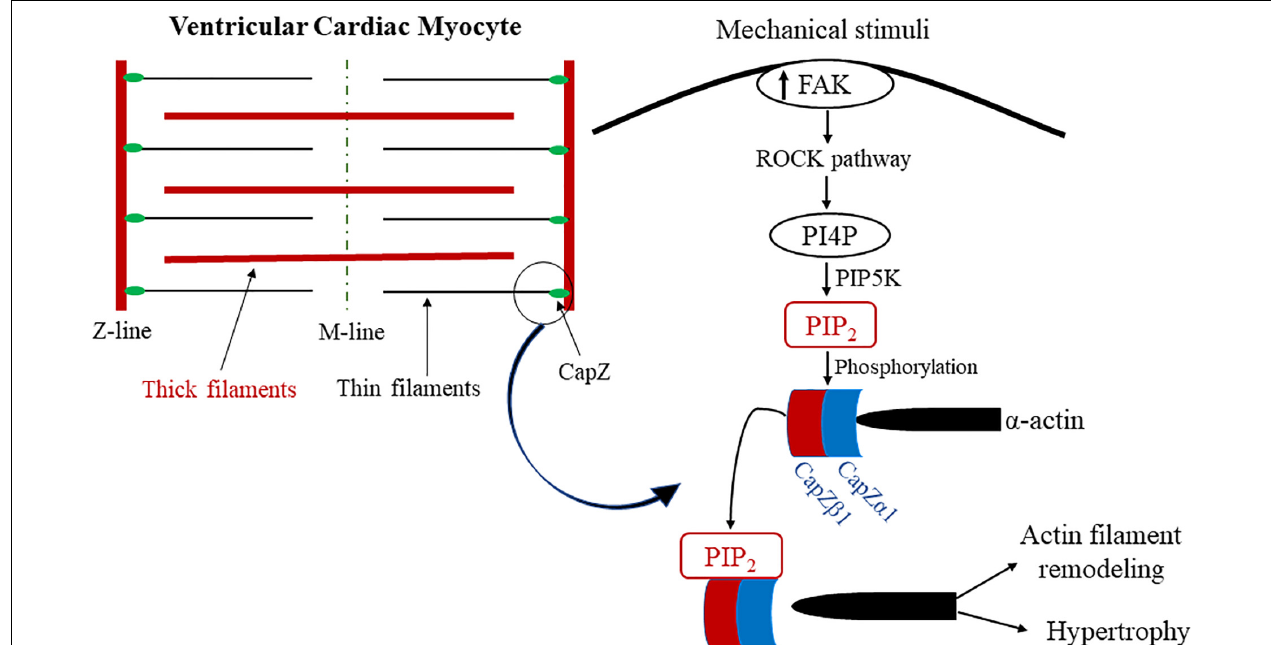
FIGURE 3 | Proposed model of PIP 2 and CapZ mechanotransduction in cardiac myocytes. Diagram of the proposed model for the mechanism of PIP 2 association with CapZ because of mechanical stimuli. Mechanical strain activates the ROCK pathway when there is an increase in mechanosensitive FAK activation, which results in PIP5K phosphorylating PI4P into PIP 2 . PIP 2 phosphorylates CapZ, which mediates its uncapping from α -actin. This results in pathological actin filament remodeling and cardiac hypertrophy. PIP 2 is highlighted in and colored red. CapZ α 1 and CapZ β 1 are colored blue to represent their association with PIP 2 as well